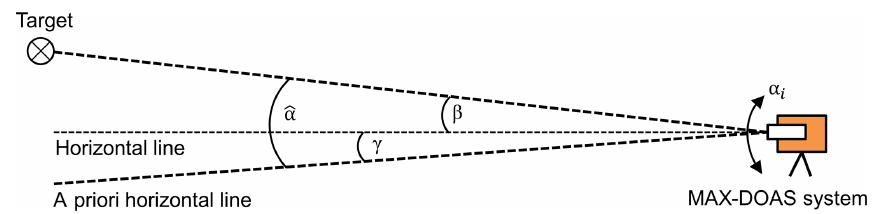
Figure 2. Sketch of the general experimental setup and angle definition used in this study. The horizontal line corresponds to the line of sight of the instrument at 0 ◦